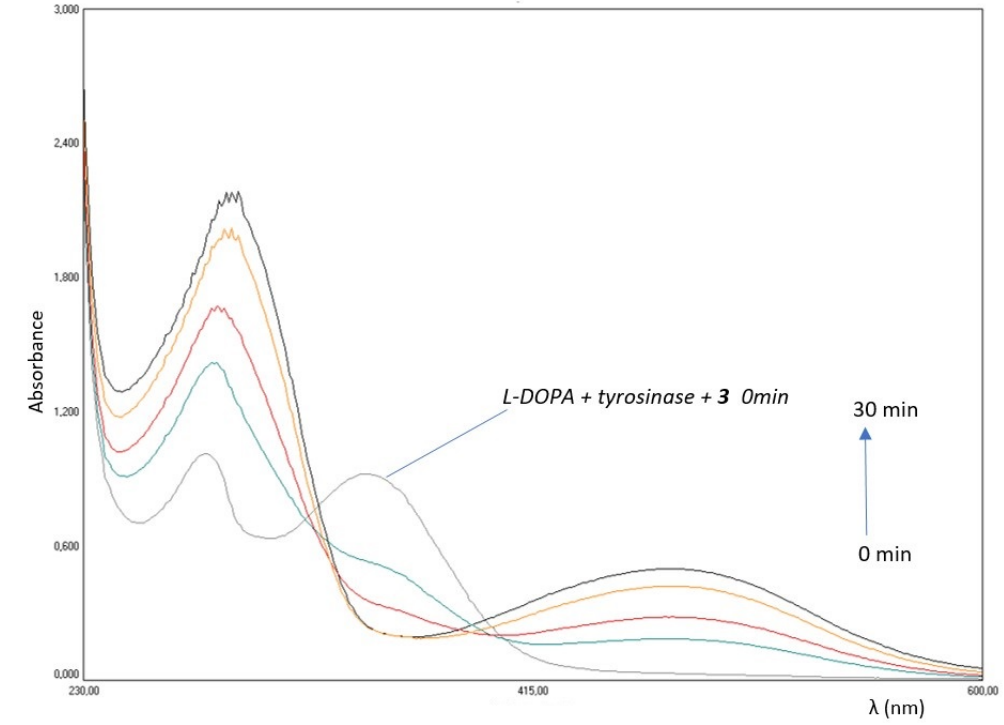
Figure 2. UV-Vis spectra obtained in the oxidation of L-DOPA by mushroom tyrosinase in the presence of inhibitors 3